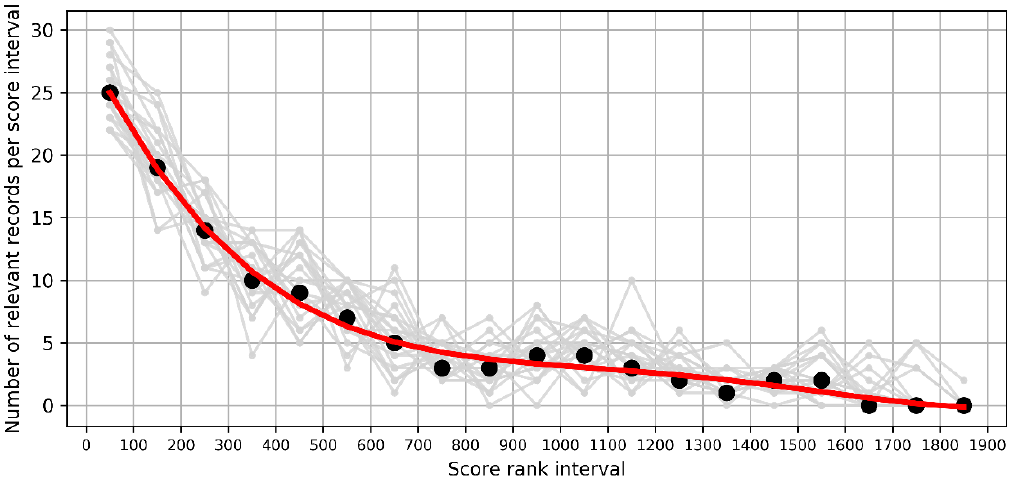
Figure 2. The distribution of the number of relevant records per score rank interval. The grey line represents the distribution of 131 relevant records according to the rank intervals for each of the 20 text scoring experiments, and the red line represents the mean number of relevant records in each score